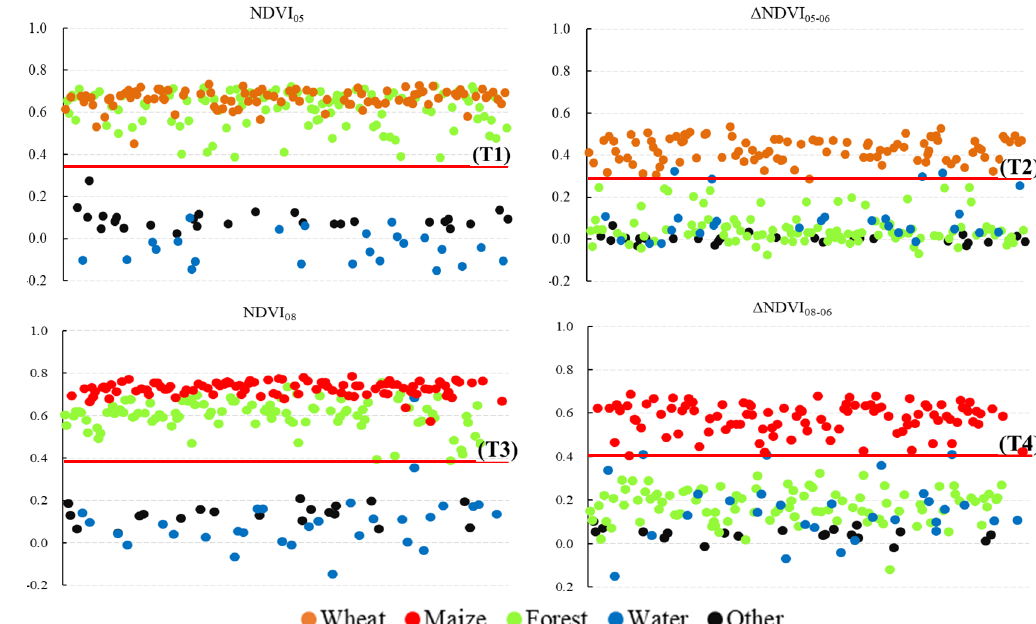
Figure 6. Comparison between the temporal profiles of normalized difference vegetation (NDVI) and NDVI time series (ΔNDVI) for the different land cover types on the North China Plain. Red lines represent the classification threshold.